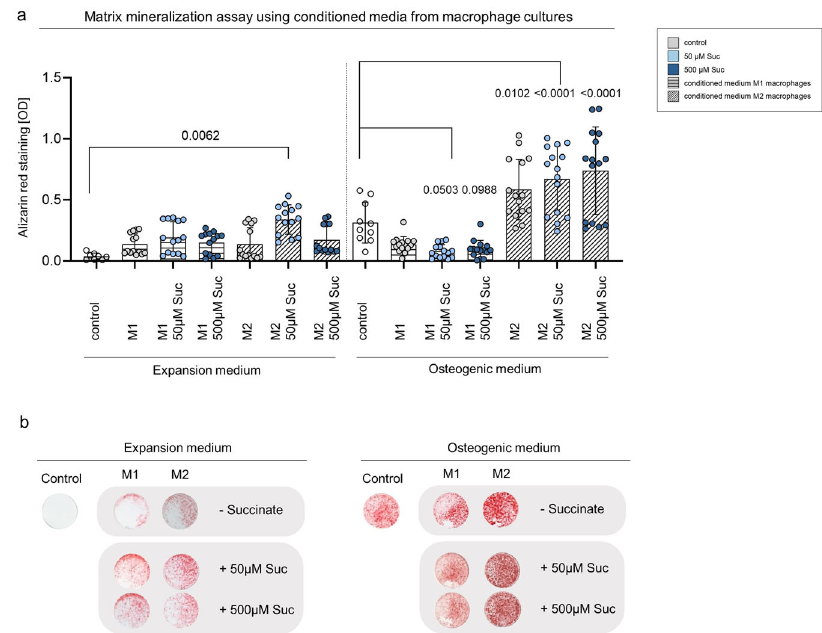
Fig. 10 In vitro osteogenic differentiation of human MSCs is highly in fl uenced by paracrine signals from conditioned medium from macrophage polarization with additive effects from succinate. a Identi fi ed mineralized matrix formation by alizarin red staining shows higher levels in osteogenic conditions when media from M2-like cultures was added to the wells. This effect was higher when M2-like macrophages were stimulated with extracellular succinate during polarization. Media from M1-like macrophage cultures showed a decreasing effect on mineralization when compared to osteogenic control conditions. Media from macrophages stimulated mineralization in control conditions (EM, expansion medium) in the absence of osteogenic differentiation factors. EM expansion medium, OM osteogenic medium, OD optical density, Suc- succinate. M1- M1-like macrophages, M2-M2-like macrophages. Pool of 3 biological replicates/donors, n = 3 individual experimental replicates for each condition for each donor, One-way ANOVA. Shown are mean ± SD. b Exemplary light microscopic picture of alizarin red staining at day 14 shown for osteogenic versus control (expansion medium) conditions and media from macrophages ± succinate treated wells. EM expansion medium, OM osteogenic medium, Suc succinate. OD optical density, M1- M1-like